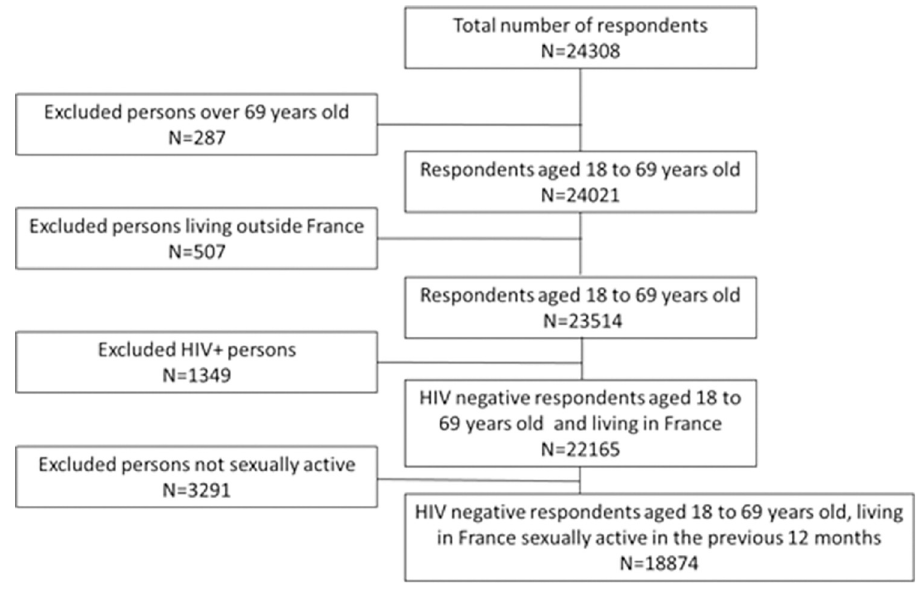
Fig 1. Participant’s flow chart in ERAS 2019 survey.